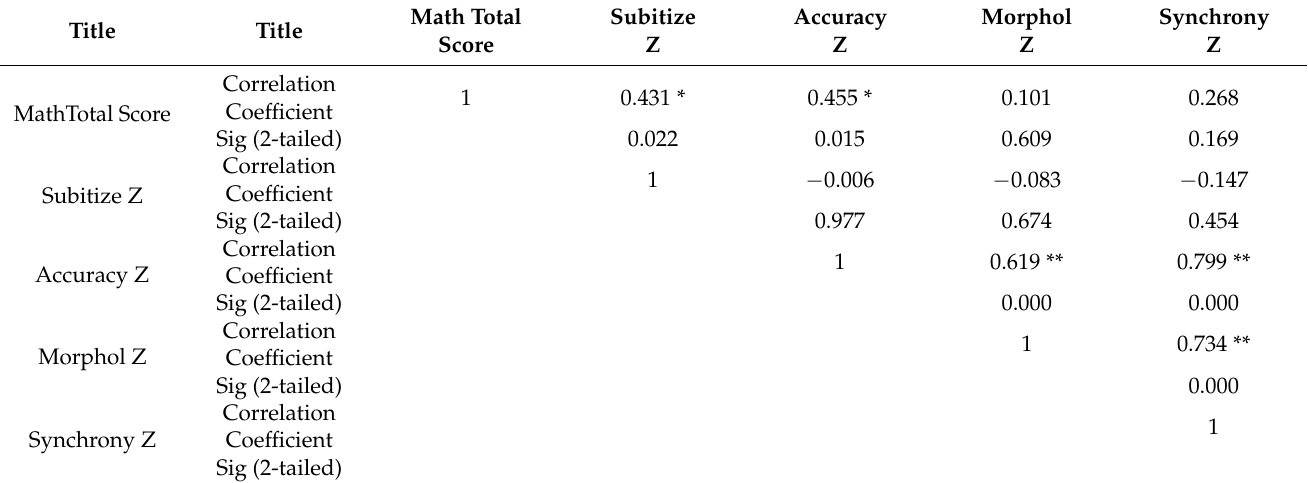
Table 11. Correlations between Math Story Total Score and Gestural Ability Measures (n =